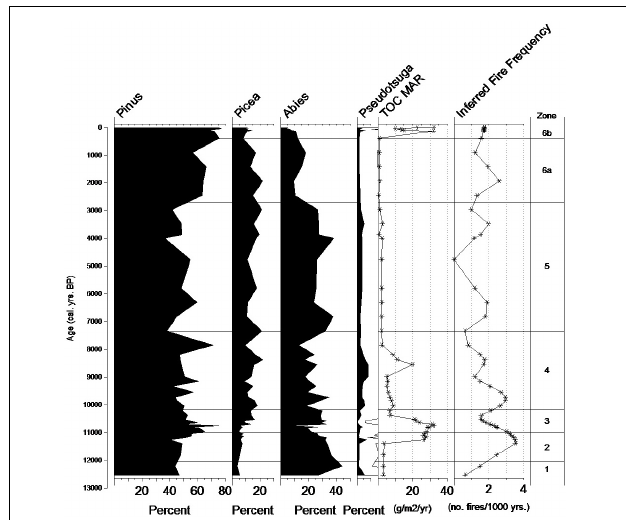
FIGURE 5 | Marion Lake: Comparison of pollen zones and percentage data for Pinus , Picea , Abies , and Pseudotsuga with TOC MAR and inferred fire frequency.